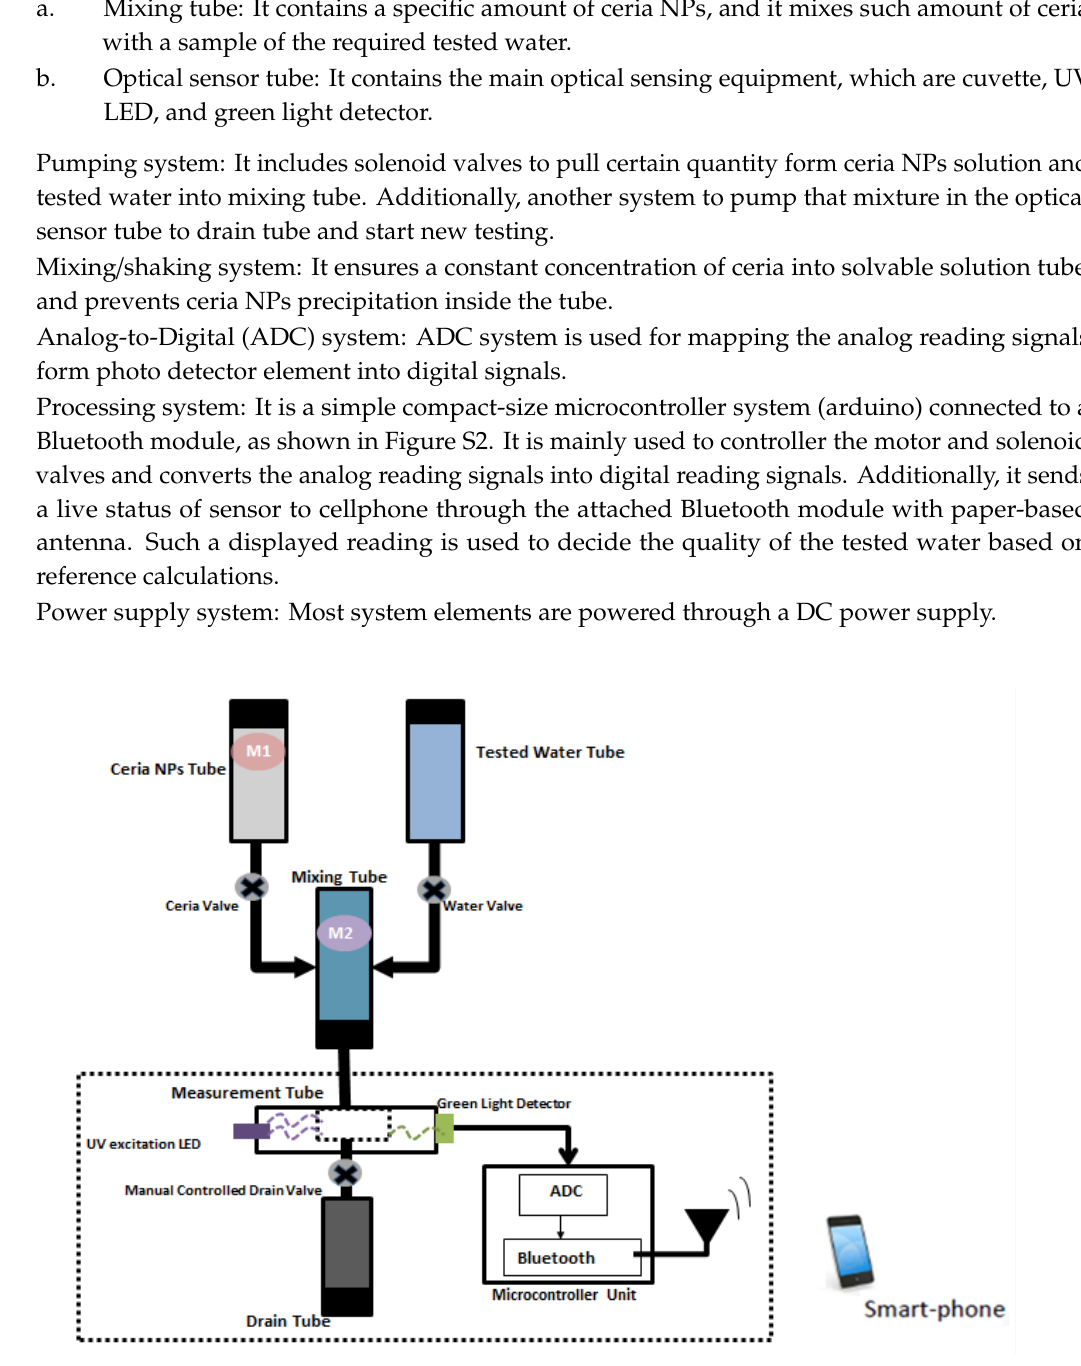
Figure 8. Schematic diagram of optical sensor unit along with communication unit.